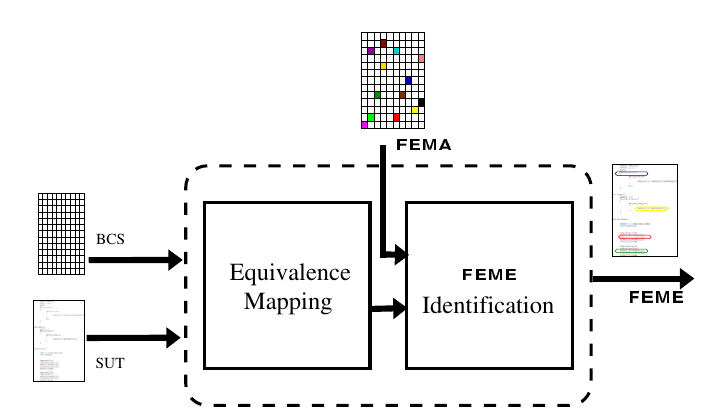
Figure 5: Fault Mapping module in FEDS , (1) Equivalence Mapping module maps all the sub-operations in BCS to program expression in the SUT, (2) FEME Identification maps all the sub-operations in FEMA to exploitable program expression FEME